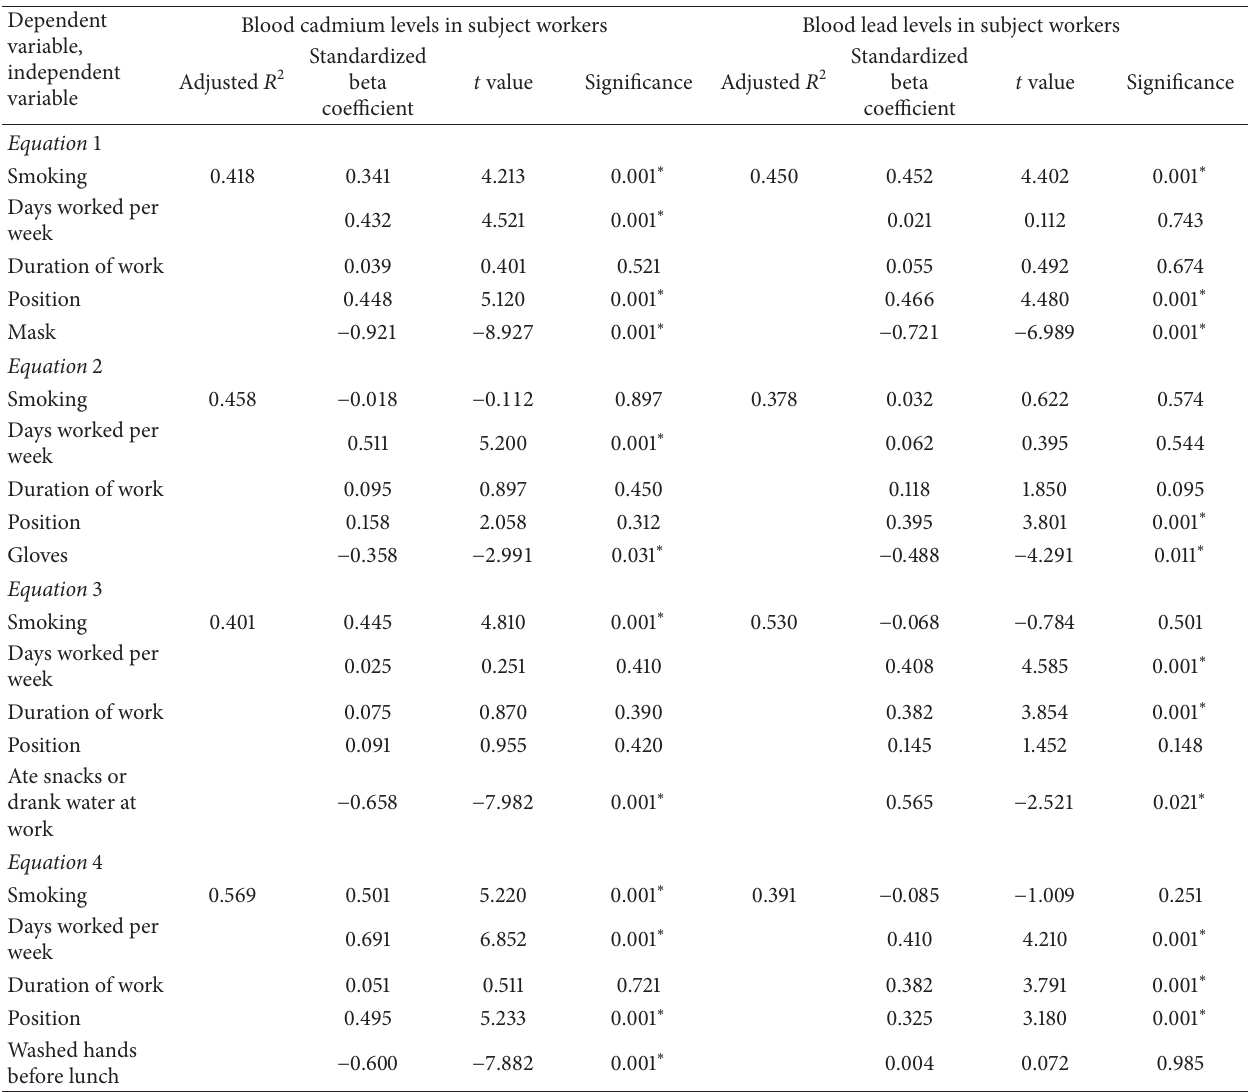
Table 6: Multiple regression occupational life style, used PPE, and personal hygiene behavior on blood cadmium and lead levels in subject workers ( 𝑛 = 114